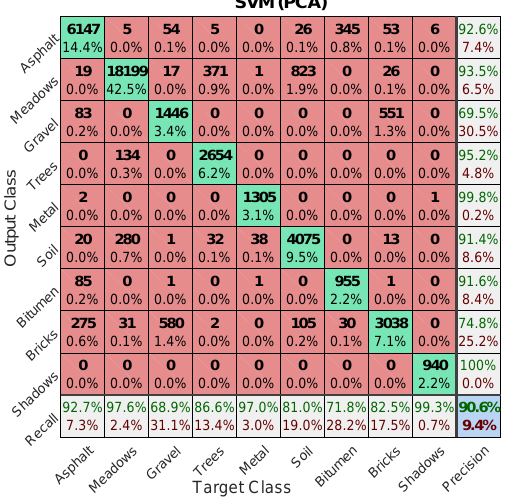
Figure 17. Confusion matrix for SVM with